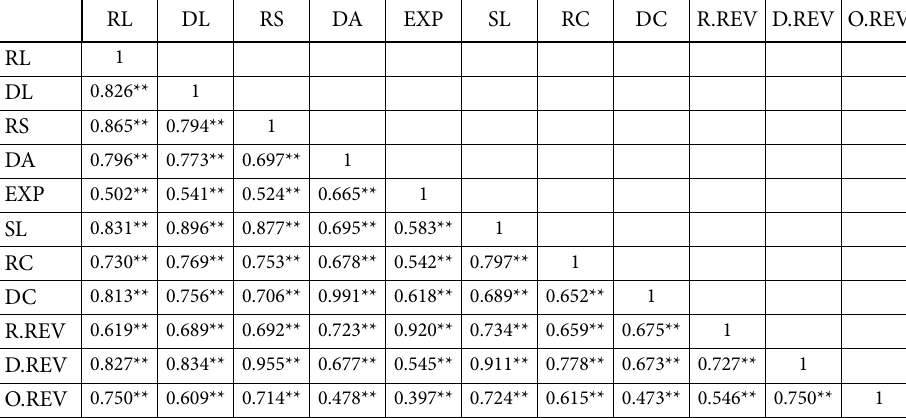
Table 3. The correlation matrix of variables set RL DL RS DA EXP SL RC DC R.REV D.REV O.REV RL